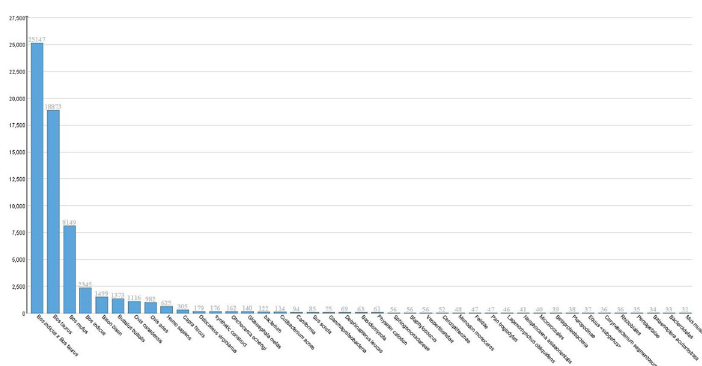
Fig 4. Taxonomic identification of de novo constructed contigs. Taxonomic distribution of de novo contig alignment against the NCBI nucleotide database, using only the top hit. The majority of hits were to Bovidae family assemblies and various mammalian species. Notably, no viral alignments were seen with the de novo contigs. The non- mammalian hits primarily consisted of bovine microbiota organisms, with few exceptions ( Basidiomycota , Onchocerca ochengi ). The total number of hits from each alignment are organized in descending order, from left to right.